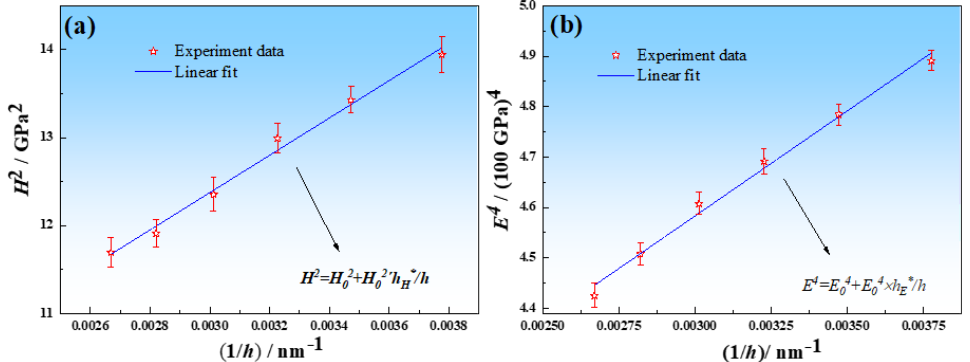
Figure 10. Linear regression of ( a ) nano-hardness and ( b ) Young’s modulus against the inverse of the displacement.